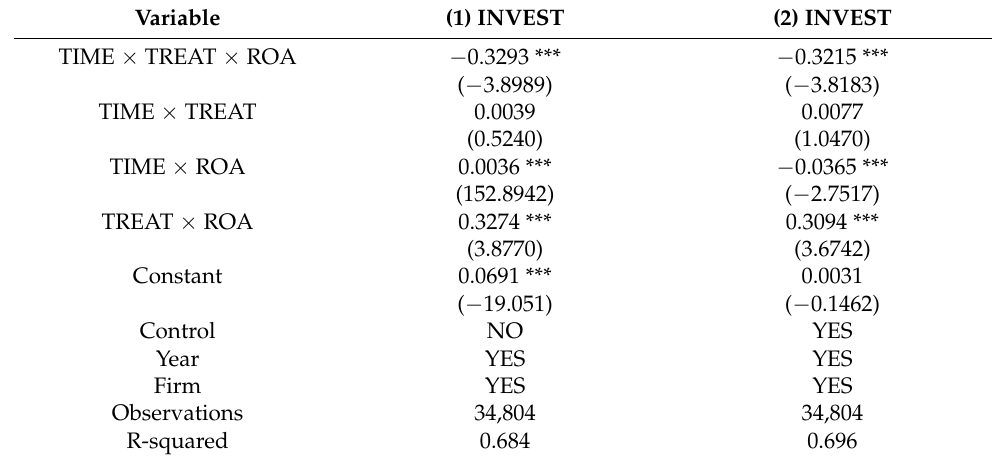
Table 9. Mediating effect.